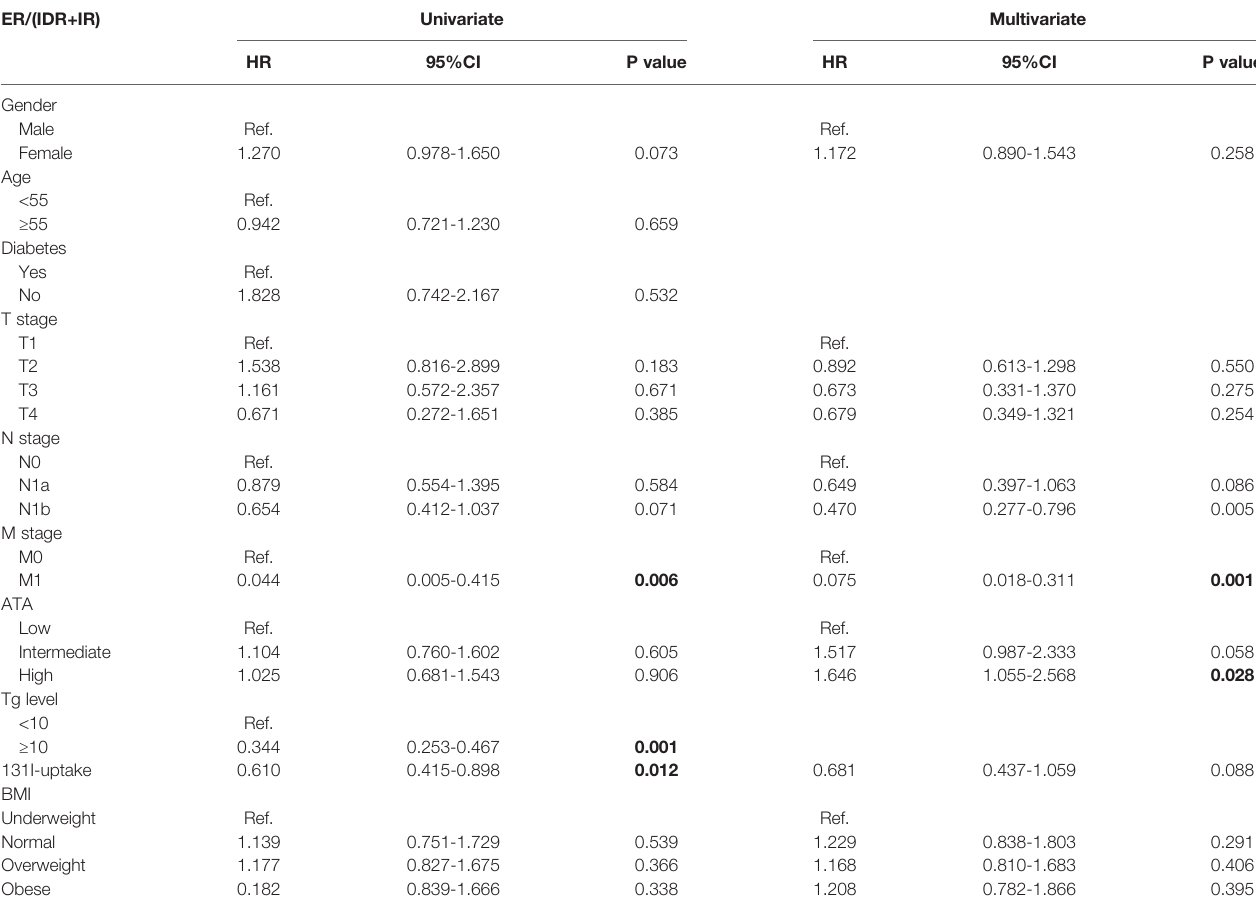
TABLE 4 | The Cox regression analysis for the initial achievement of ER to RAI